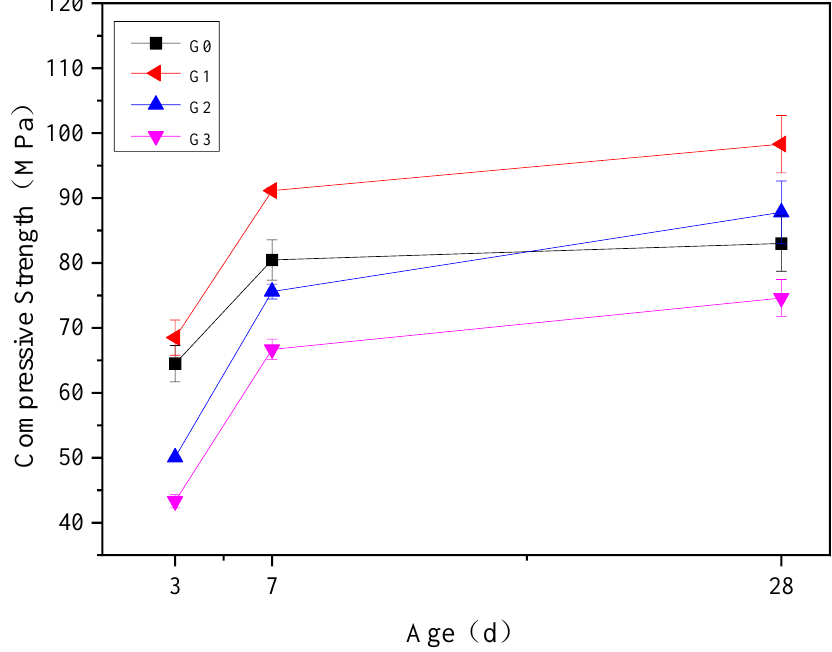
Figure 4. Compressive strength of APC pastes with different anhydrite contents. The compressive strength development results indicate that an appropriate dosage of anhydrite promoted the hydration of APC. The compressive strength of the G1 group with an anhydrite content of 15% was the highest at all curing ages. At age 28 d, its compressive strength was nearly 20% higher than the sample without any anhydrite.